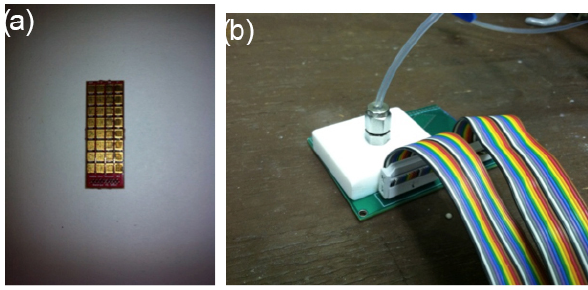
Figure 1. The sensor chip fabricated on a printed circuit board. (a) A 32 sensor array chip and (b) gas exposure